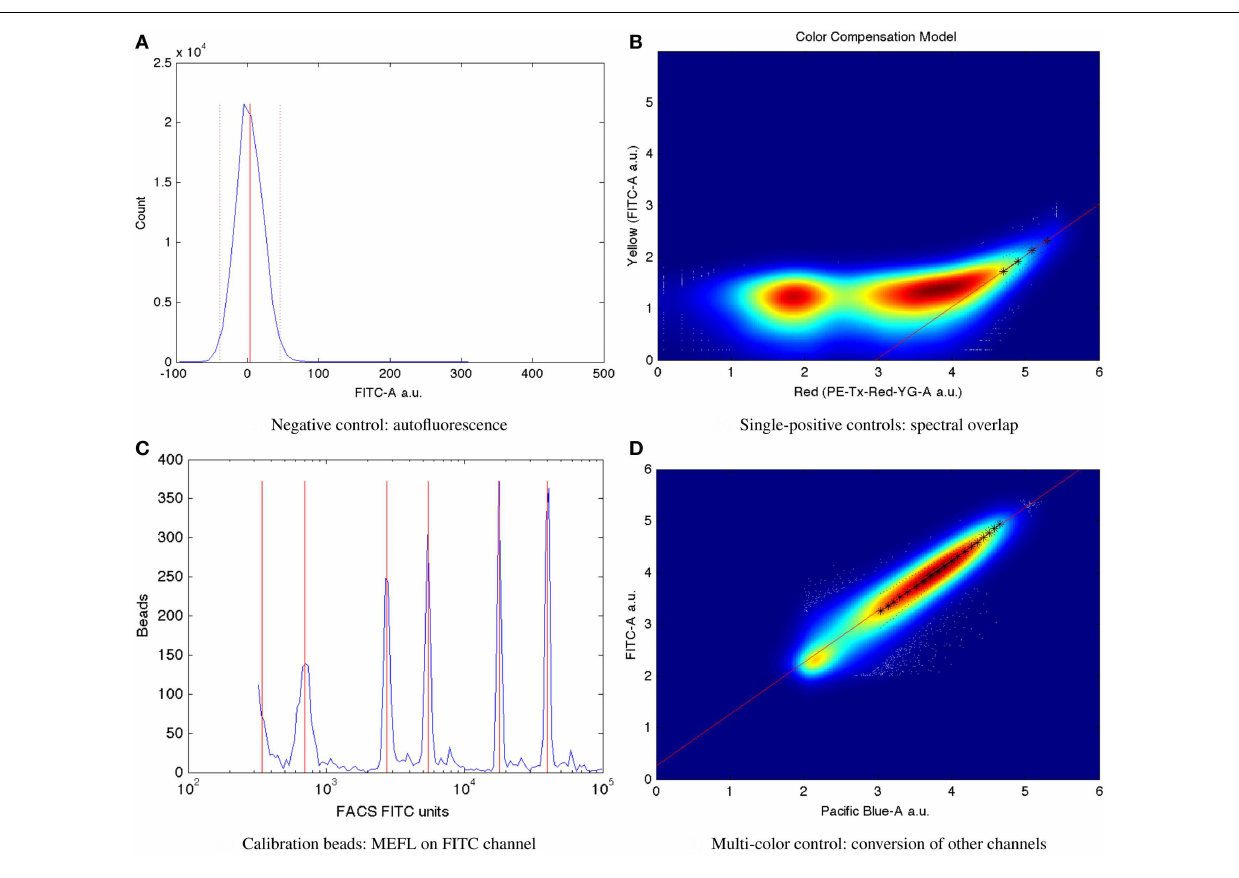
positive control. (C) Computation of from MEFL conversion factor from calibration beads. (D) Computation of color conversion factor from multi-color